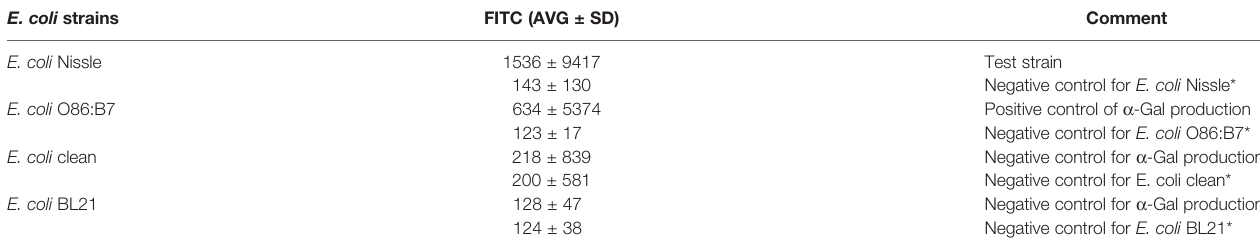
TABLE 2 | Presence of a -Gal in E. coli Nissle measured by fl ow cytometry. E. coli